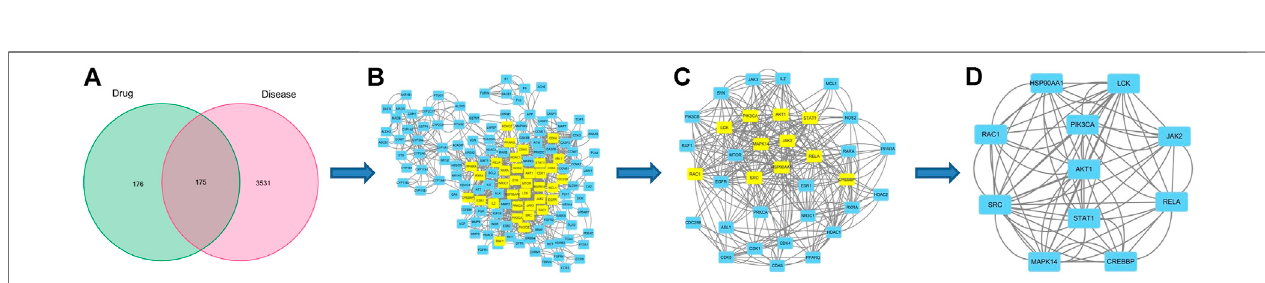
FIGURE 5 | Identi fi cation of PTE-STC target genes and construction of the PPI network. (A) PTE target gene prediction for STC treatment. The 175 genes were considered the molecular targets of PTE against STC. (B) The PPI network of PTE-STC targets constructed by Cytoscape. (C) The PPI network of signi fi cant proteins extracted from (B) ; (D) The PPI network of core targets for STC treatment obteined from (C) .